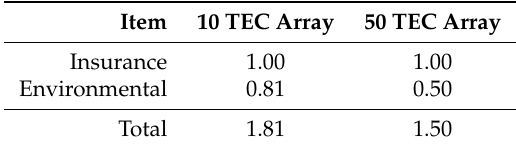
Table 5. RM1 annual OPEX contributions from externalities in 1 dollars at the rate of 1 $ = 0.85 (cid:100) ).